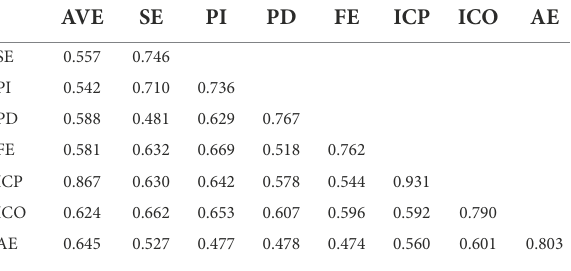
TABLE 3 Square root and correlation coefficient of mean extracted